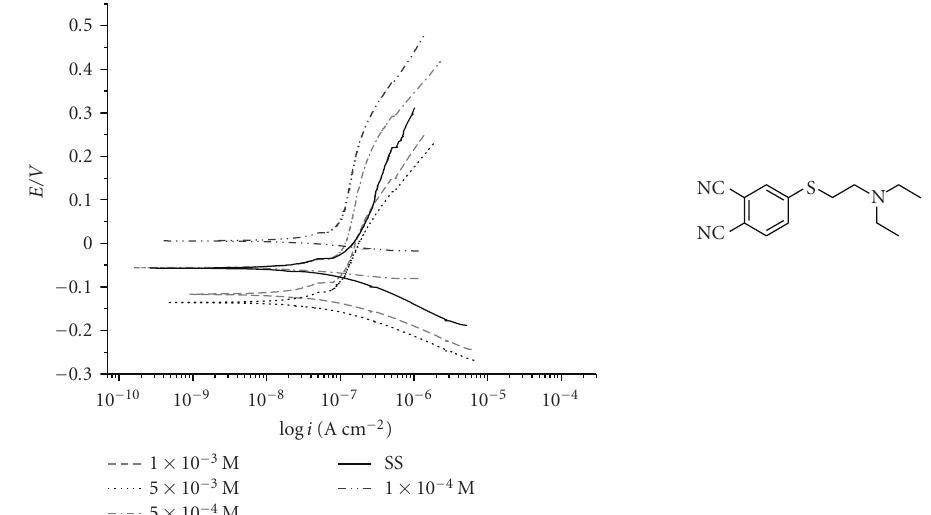
Figure 1: Polarization curves of stainless steel in the presence and absence of di ff erent concentrations of 4-(2-diethylamino-ethylsulfanyl)- phthalonitrile (DAESPN) in 3.0M NaCl medium. Table 1: Corrosion values SS in the presence and absence of di ff erent concentrations of DAESPN and Bis-HSPN in 3.0M NaCl medium.